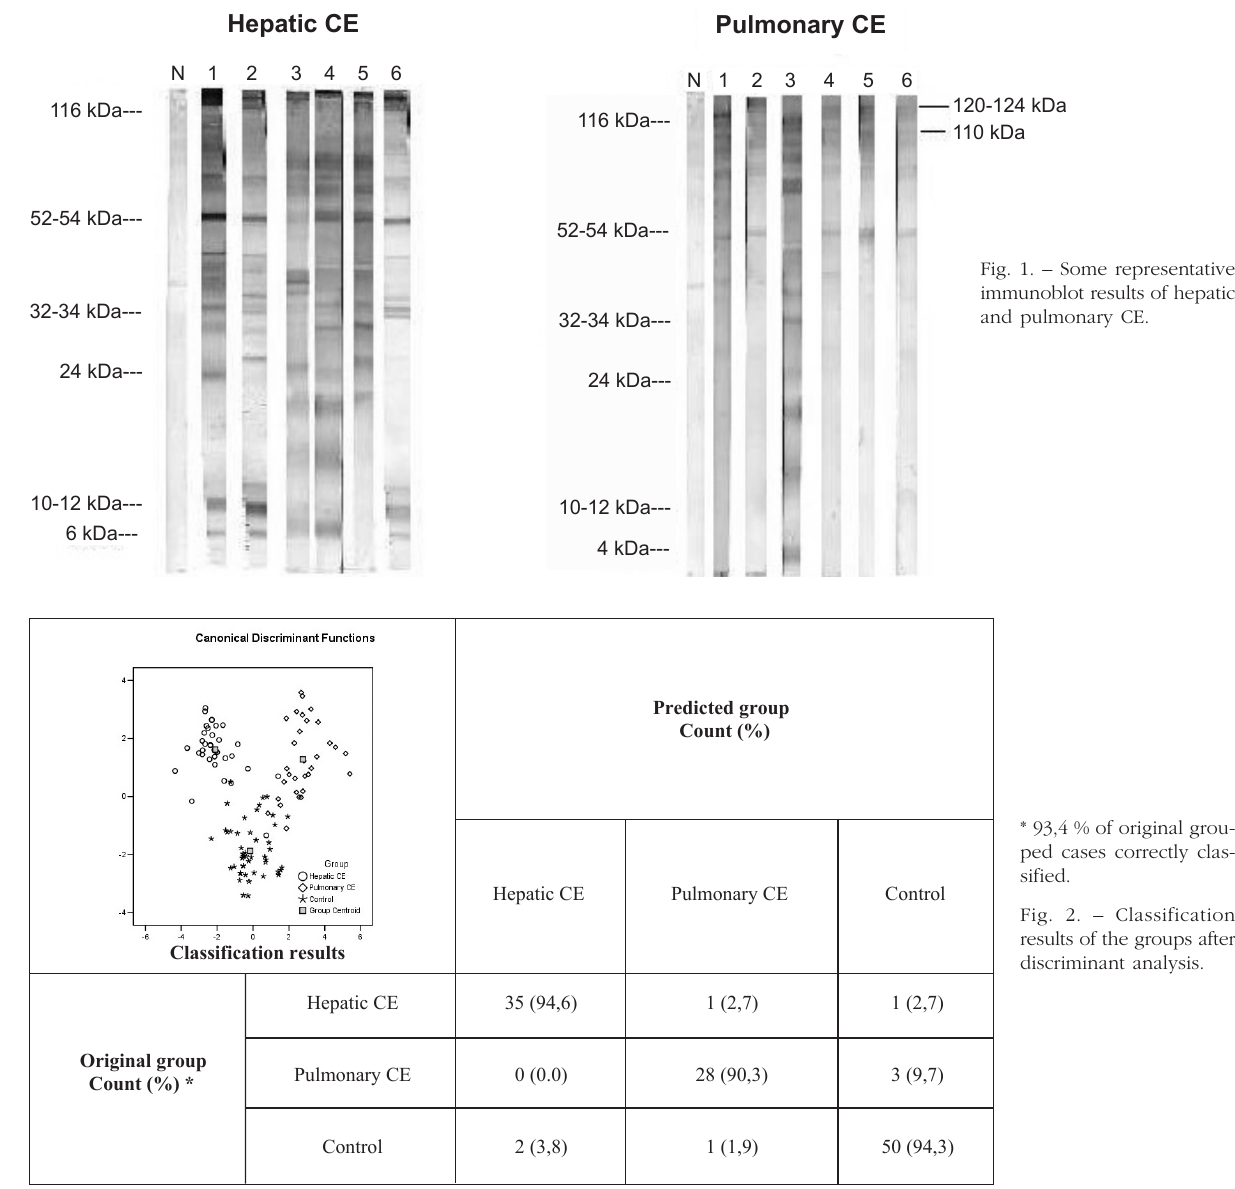
Fig. 1. – Some representative immunoblot results of hepatic and pulmonary CE.